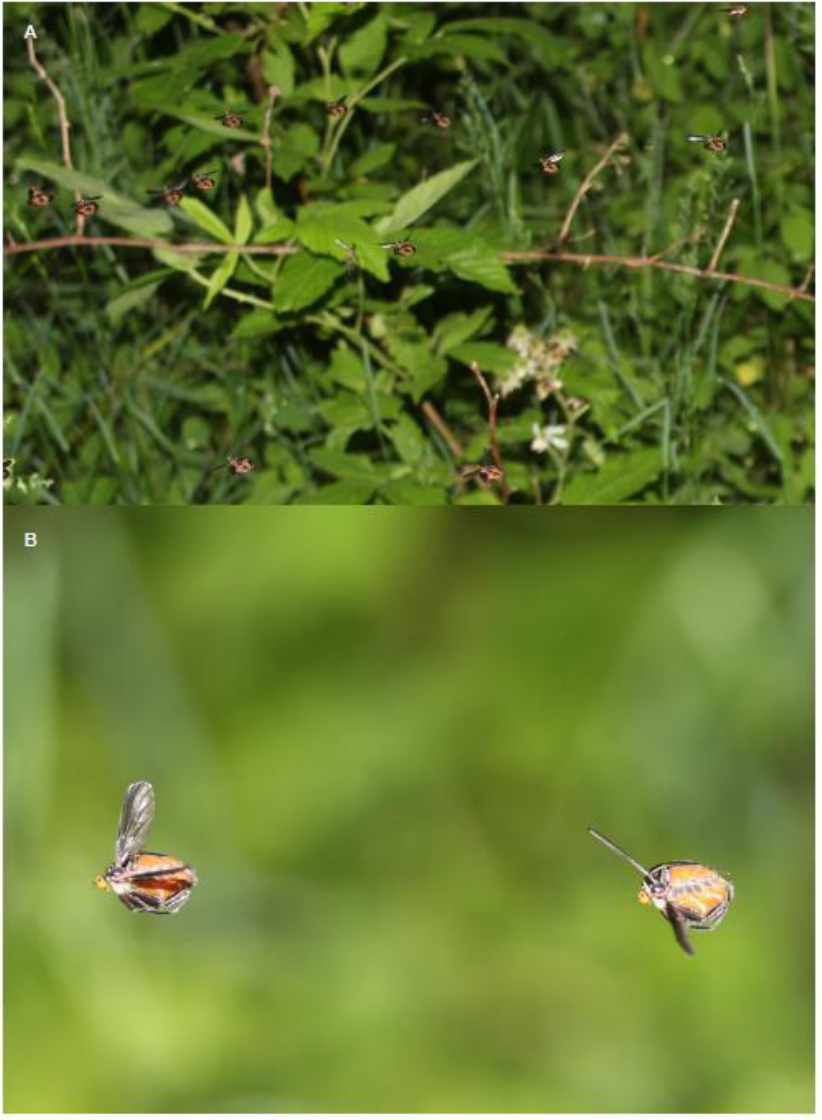
Figure 1. Rhamphomyia longicauda mating swarm. ( A ) A female-biased mating swarm showing 13 females displaying multiple ornaments and one male (centre) carrying a nuptial gift. ( B ) Two female R. longicauda individuals in a mating swarm displaying their ornaments — extended abdominal sacs and three pairs of legs with extensive pinnate leg scales. Reprinted with permission from John Alcock.